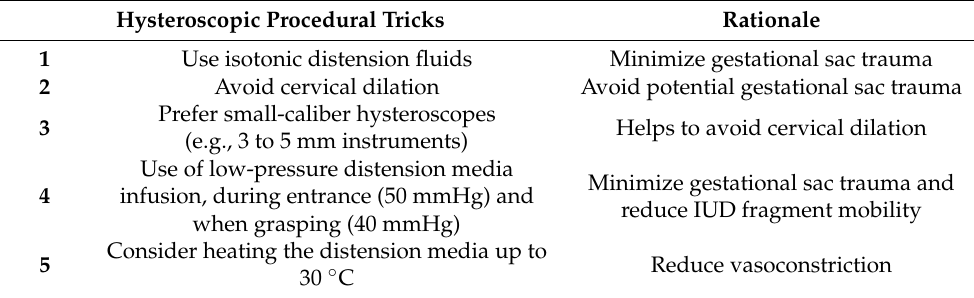
Table 2. Procedural tricks for the hysteroscopic removal of IUD